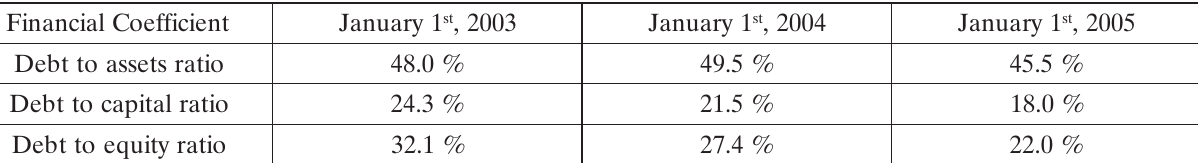
Table 1. Values of Financial Coefficients for Company